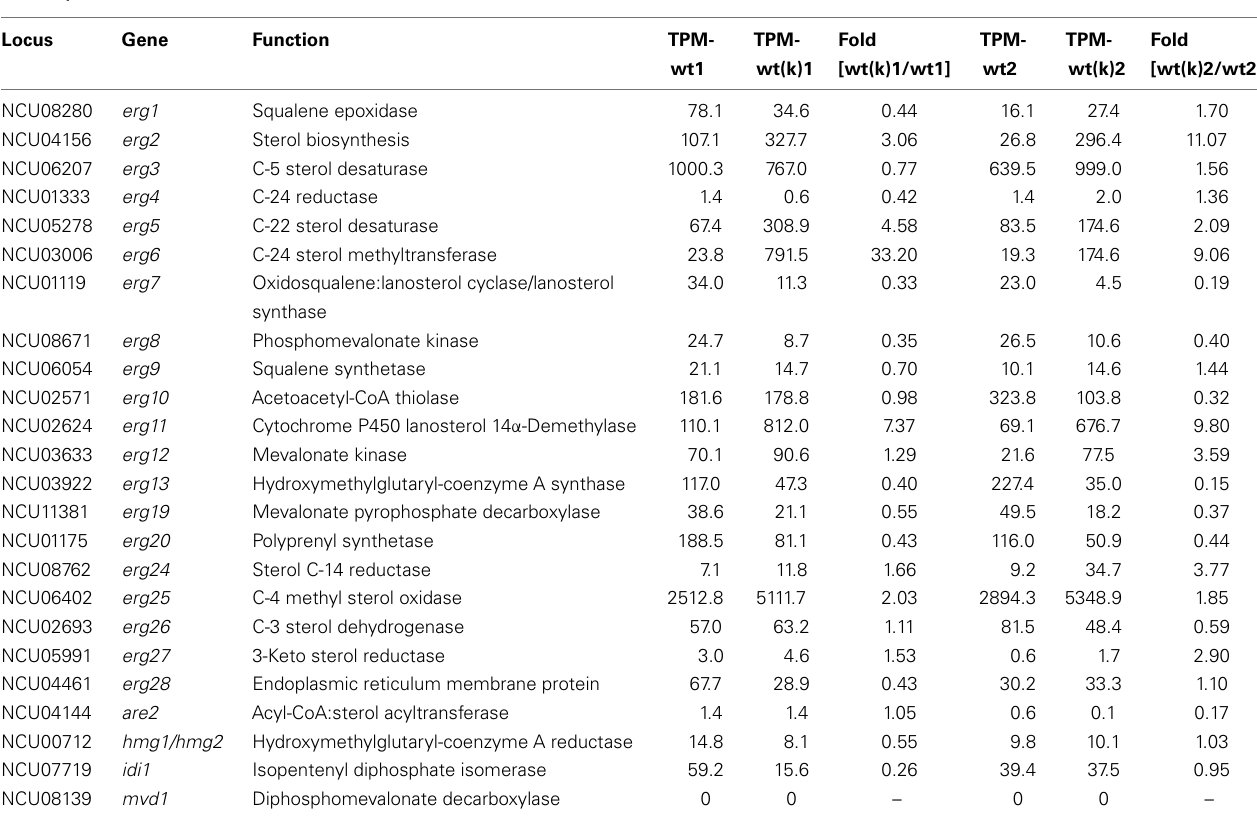
Table 3 |Transcriptional response to ketoconazole stress by genes involved in ergosterol biosynthesis in N. crassa wild type.